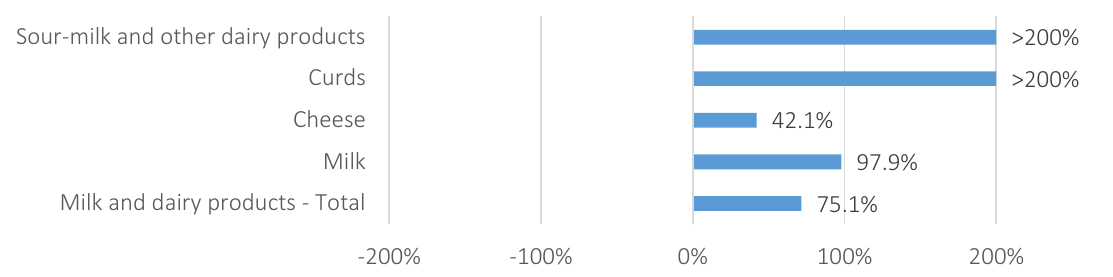
Figure 6. Average consumption for segment 2